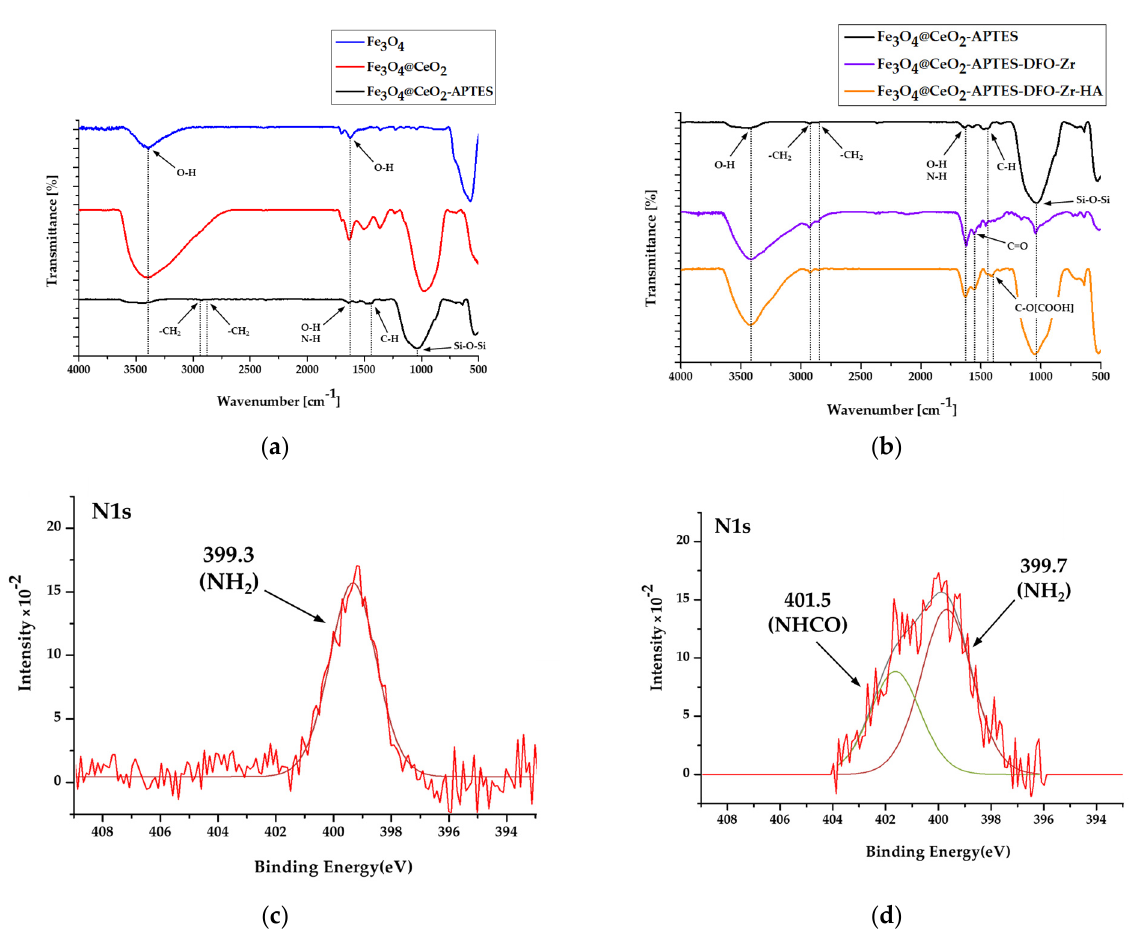
Figure 2. Fourier transform infrared spectroscopy (FT-IR) spectra of: ( a ) Fe 3 O 4 , Fe 3 O 4 @CeO 2 and Fe 3 O 4 @CeO 2 -APTES; FT-IR spectra of ( b ) Fe 3 O 4 @CeO 2 -APTES, Fe 3 O 4 @CeO 2 -APTES-DFO and Fe 3 O 4 @CeO 2 -APTES-DFO-Zr-HA; X-ray photo- electron spectroscopy (XPS) spectra of ( c ) N1s of Fe 3 O 4 @CeO 2 -APTES; and ( d ) N1s of Fe 3 O 4 @CeO 2